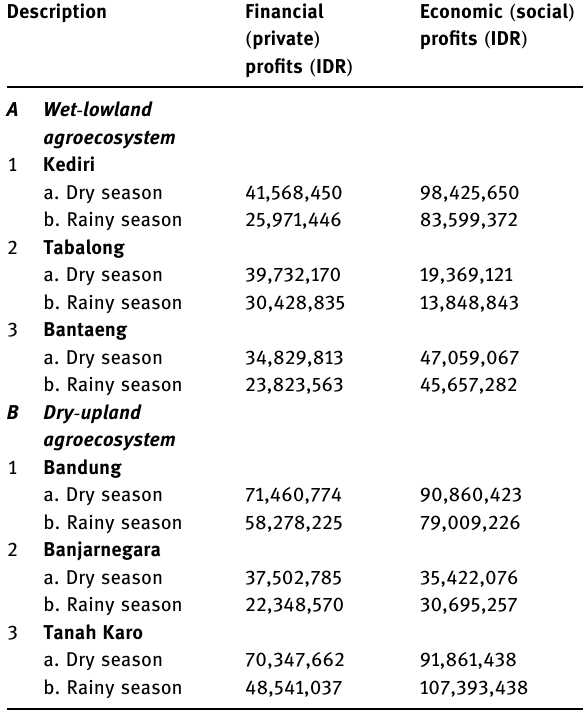
Table 2: Private and social pro fi ts of chili farming in research locations, dry season of 2019 and rainy season of